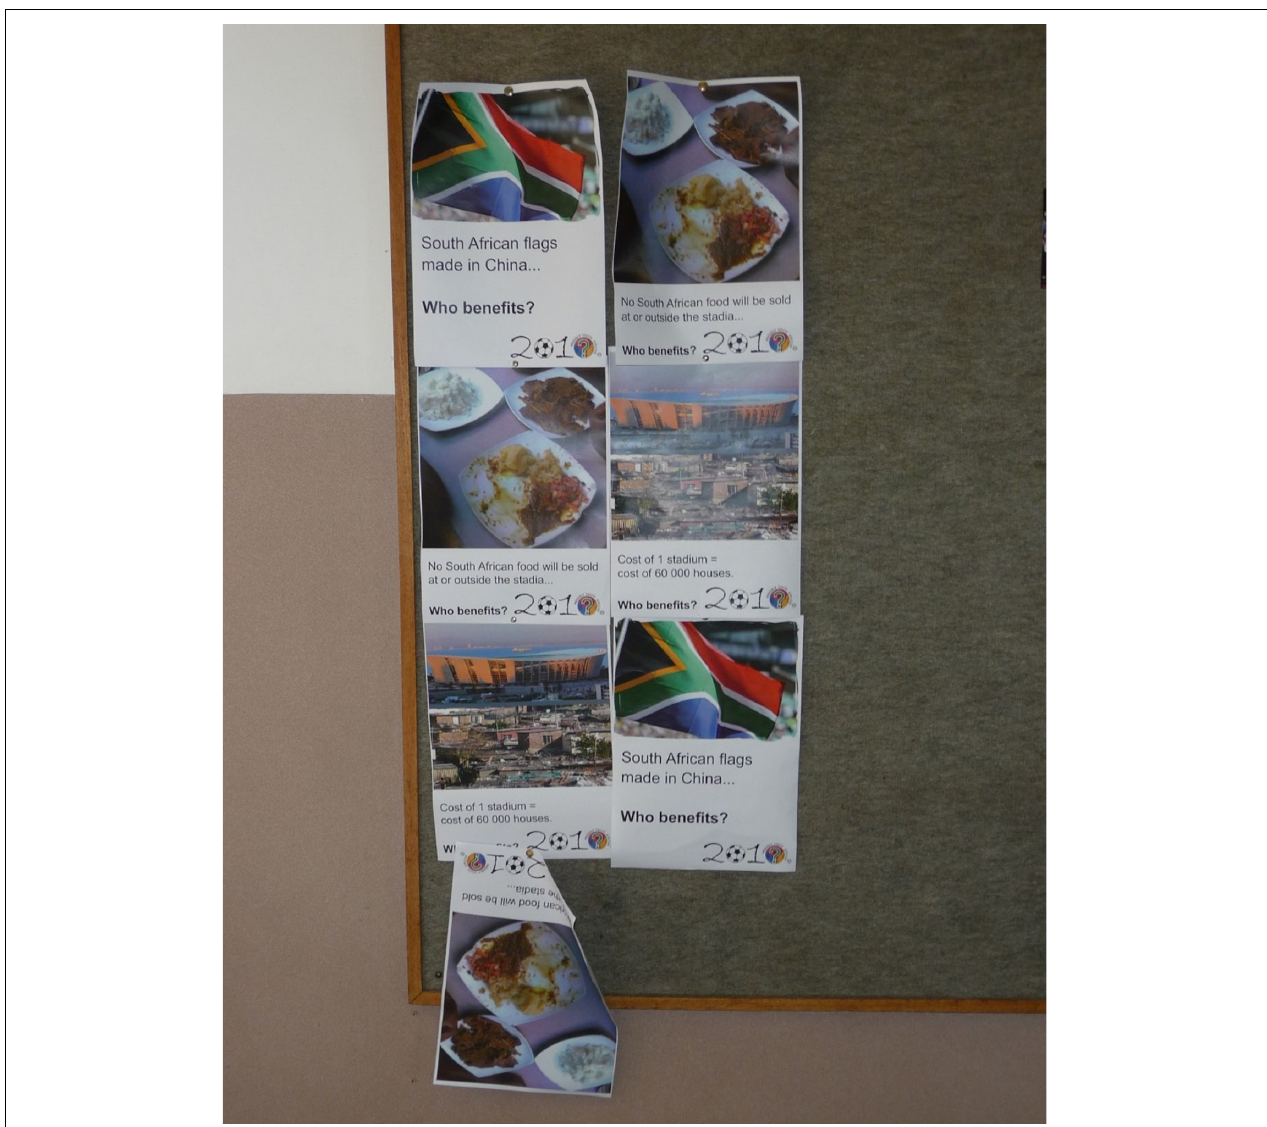
FIGURE 4 | “Who benefits” posters critical of the World Cup displayed on the University of the Witswatersrand Campus.